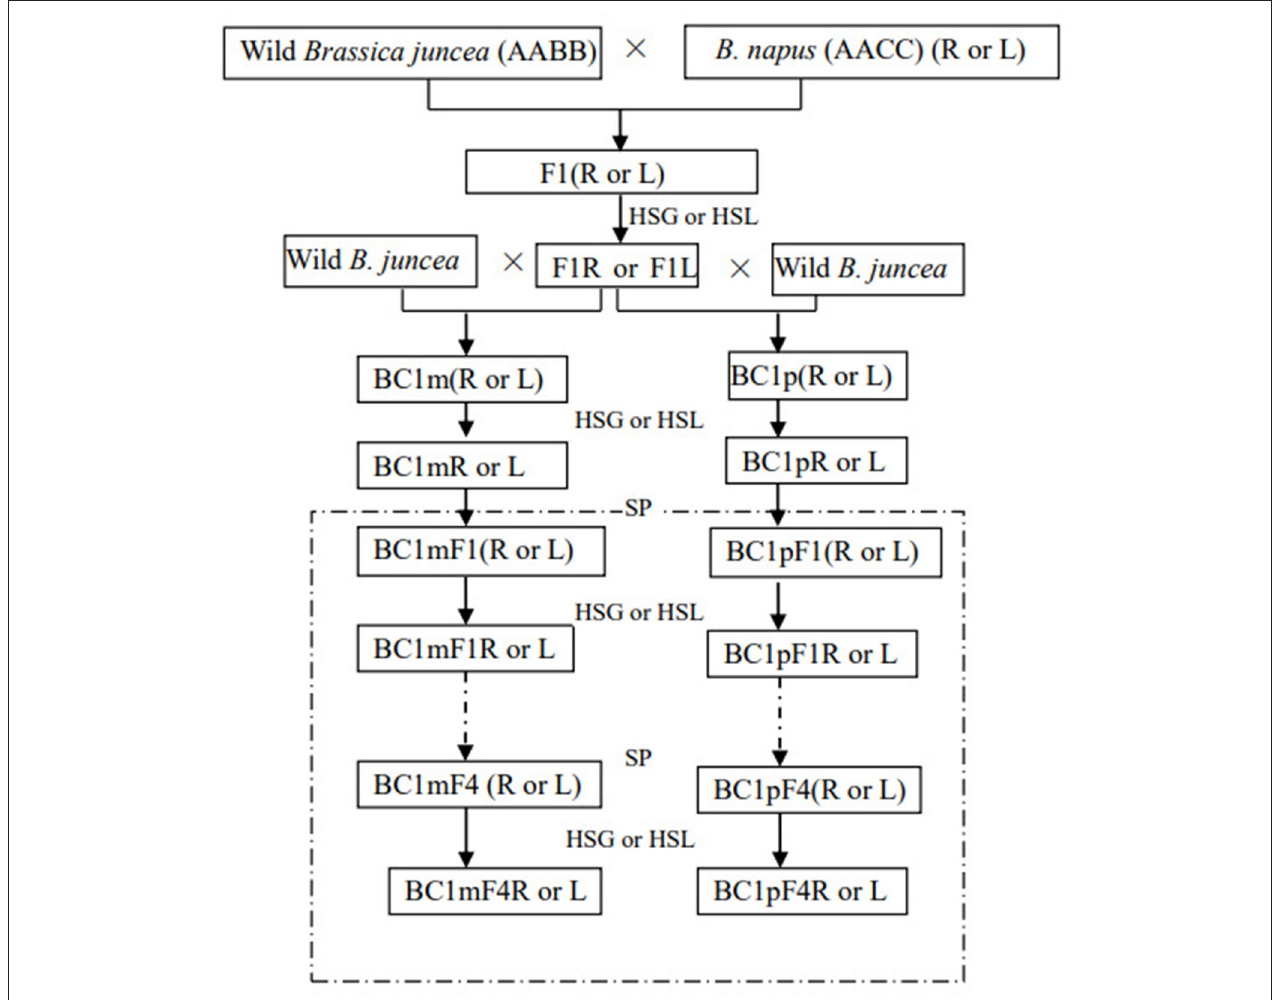
FIGURE 1 | Crossing scheme for the hybridization and backcrossing of wild Brassica juncea and transgenic herbicide-tolerant oilseed rape, and self-pollination of the first backcross generation (BC1). Combinations involved in this study are indicated as maternal plants × paternal plants. m and p indicate the backcross generations obtained with wild Brassica juncea as the maternal and paternal plants, respectively. (R) and (L) indicate the F1, the first backcross generation, and its progeny obtained by using the transgenic glyphosate- or glufosinate-tolerant oilseed rape as the paternal plants, respectively. R means glyphosate-tolerant transgenic oilseed rape, F1, and backcross generation. L means glufosinate-tolerant transgenic oilseed rape, F1, and backcross generation. BC1F1 to BC1F4 are the first- to fourth-generation progenies of the first backcross generation (BC1). SP indicates self-pollination, and HSG and HSL indicate herbicide selection by glyphosate or glufosinate,